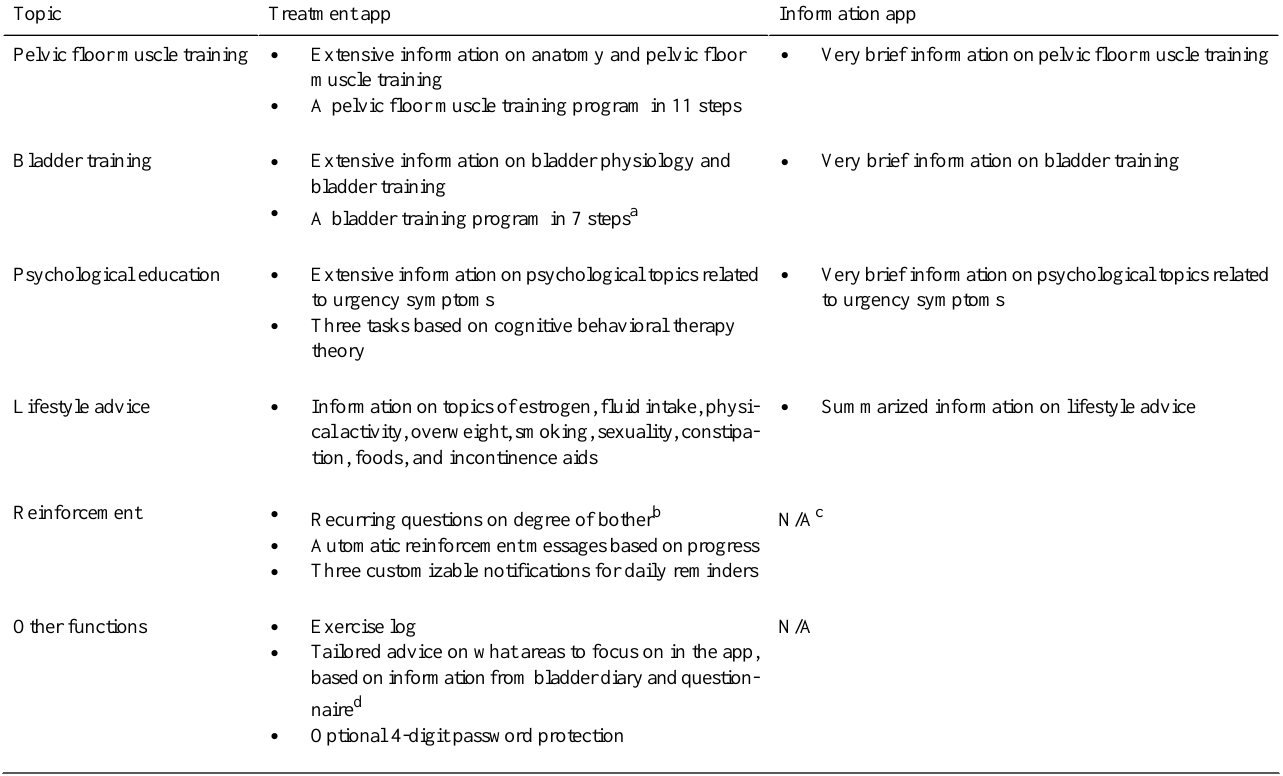
Table 1. Contents of the Tät II treatment app and information app.